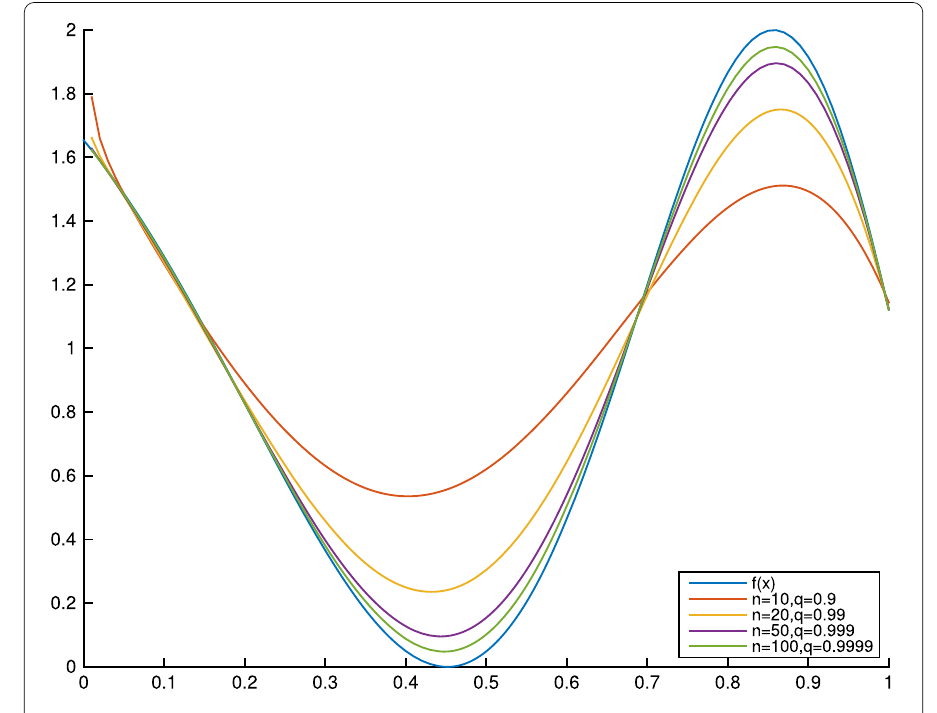
Figure 1 Convergence of T n , q , α ( f ; x ) to f ( x ) for fixed α = 0.9